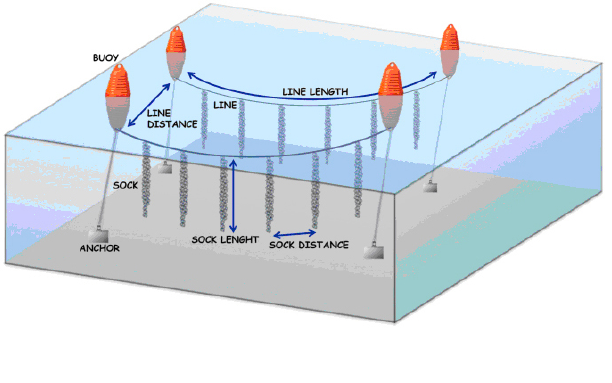
Fig. 7 . Design of a typical mussel farm in Taranto. The plan is arranged through the repetition of a basic unit, called “camera,” made with stakes driven into the bottom. The camera is always a square, laterally bounded and diagonally crossed by “lines.” Socks containing mussel nets are suspended from each line. This customary farming plan has recently been updated with polyethylene floats, known as “long lines,” which are a modern variant of the traditional system. Both systems are currently used in Mar